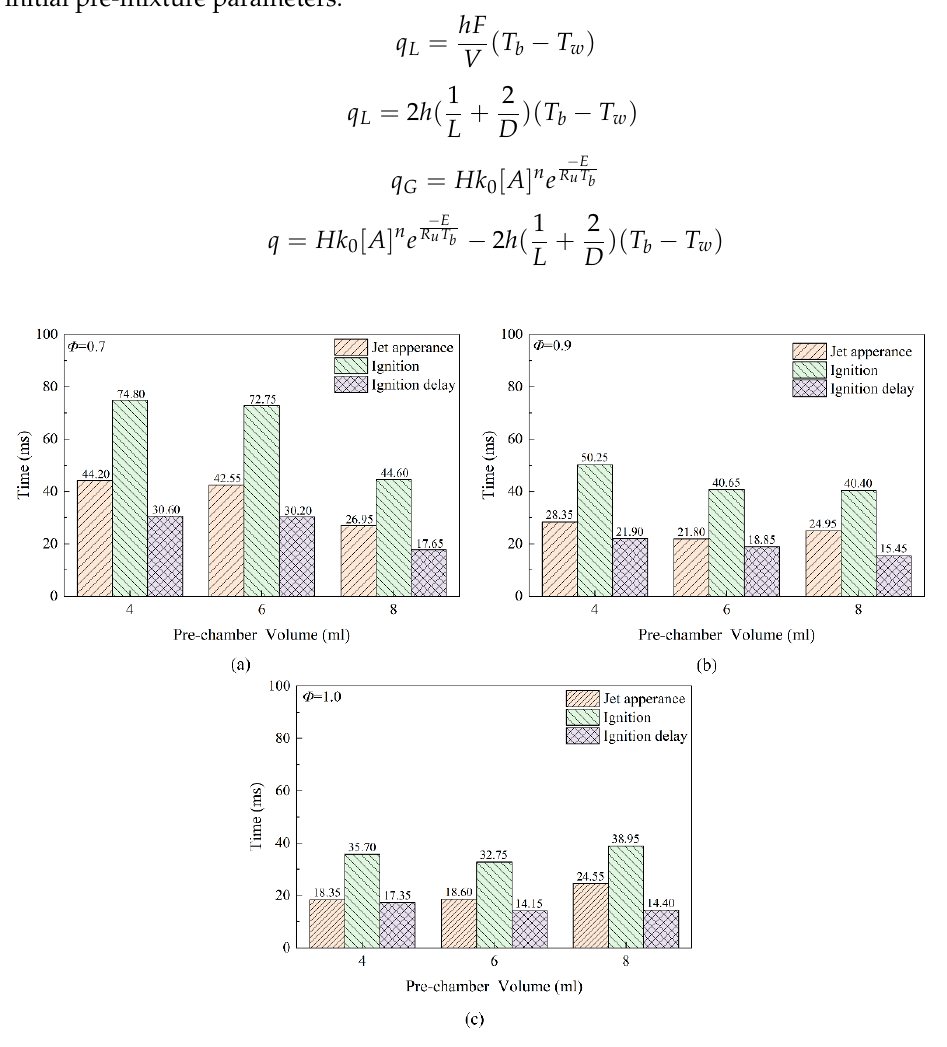
Figure 7. Jet appearance timings, ignition timings in the main chamber, and ignition delays for different pre-chamber volumes at different equivalence ratios.